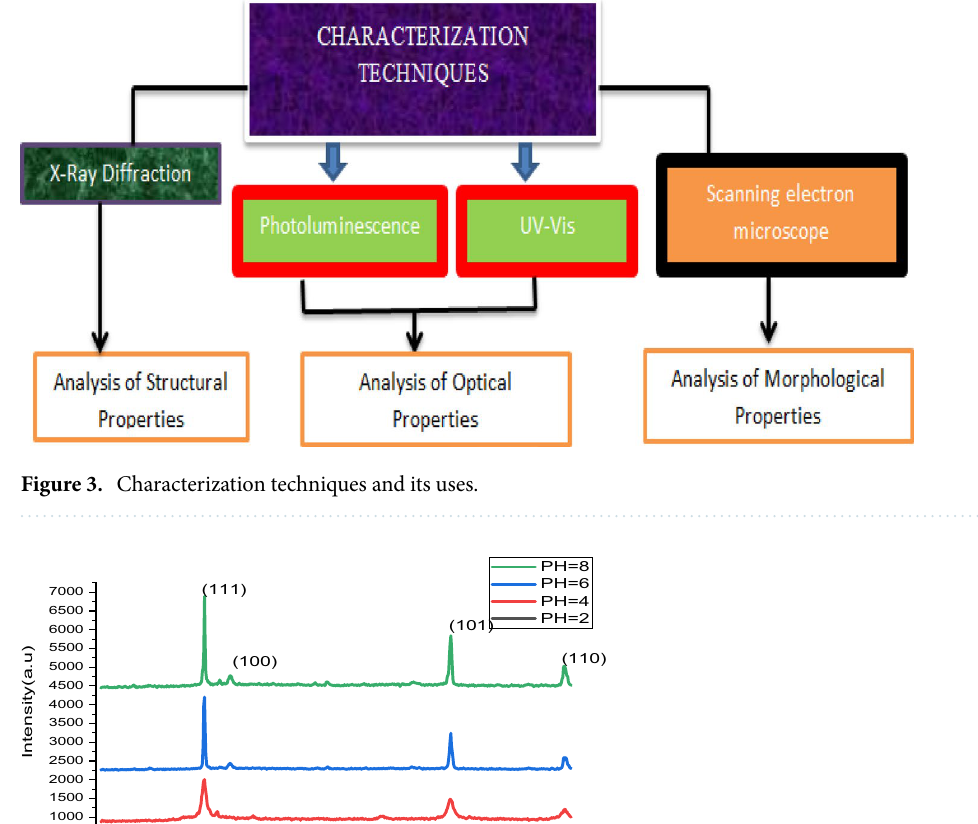
Figure 4 revealed the XRD configuration gained from the Lead Sulfide thin film. The detected crests were indexed with a cubic shock salt kind configuration, as inveterate through a standard (JCPDS N0. 05-0592) as well as they are epitomized by their consistent indices in the continuums. The constricted crests display that the materials have respectable crystal nature with very tougher specially oriented along the planes (100), (111), (101) and (110), which strength is predominantly liable on the preparation times. Furthermore, the nonappearance of extra peaks conforming to metal clusters and impurity tells virtuous qualities of the thin film. An average crystal size (0.5 nm) was calculated through Debye- Scherer’s formulas 12,33 . K (cid:31) (5) D = β Cos θ